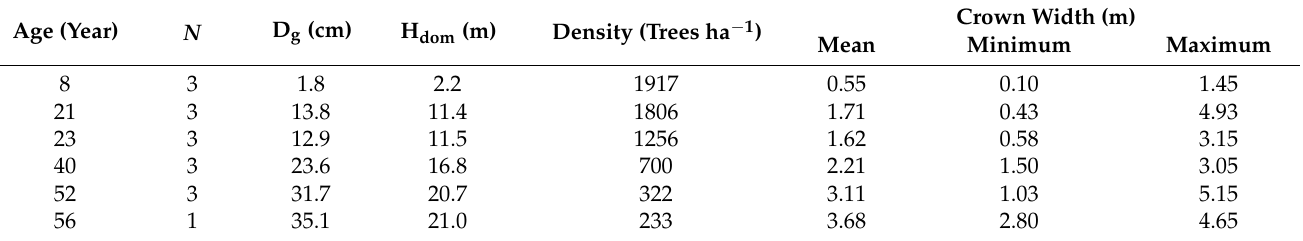
Table 1. Statistics of the stand age, diameter at breast height (DBH), quadratic mean diameter (D g ), dominant tree height (H dom ), density and crown width of the six forest stands used to conduct destructive tree sampling in Dabiangou forest farm. N is the number of the sample plot selected in each forest stand to conduct destructive tree sampling.